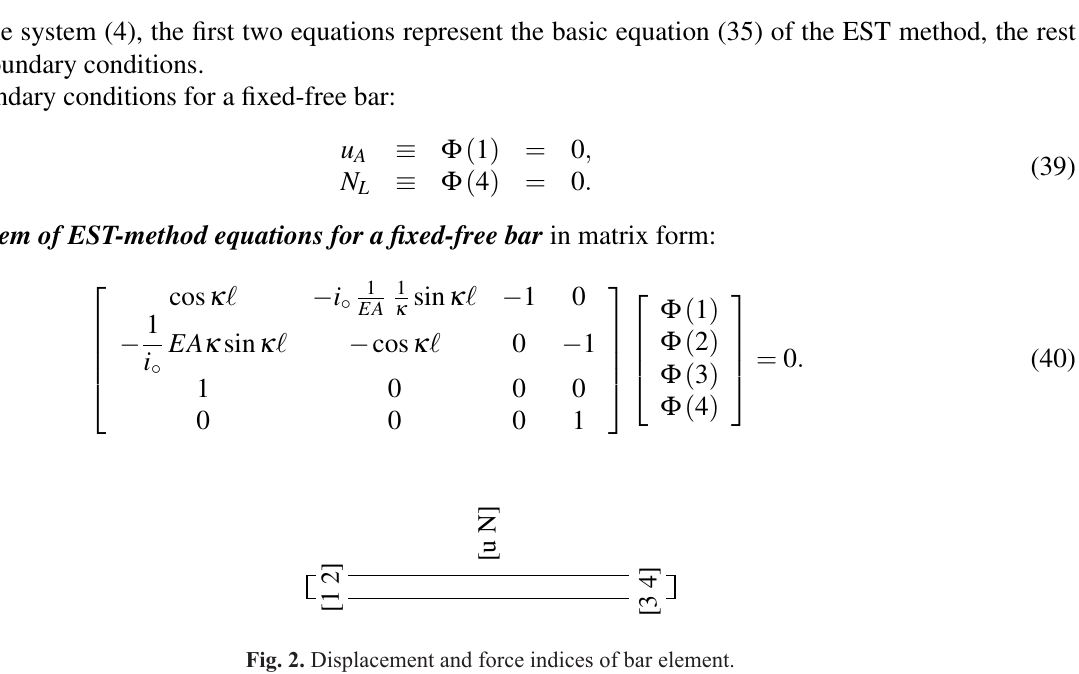
Fig. 2. Displacement and force indices of bar element.